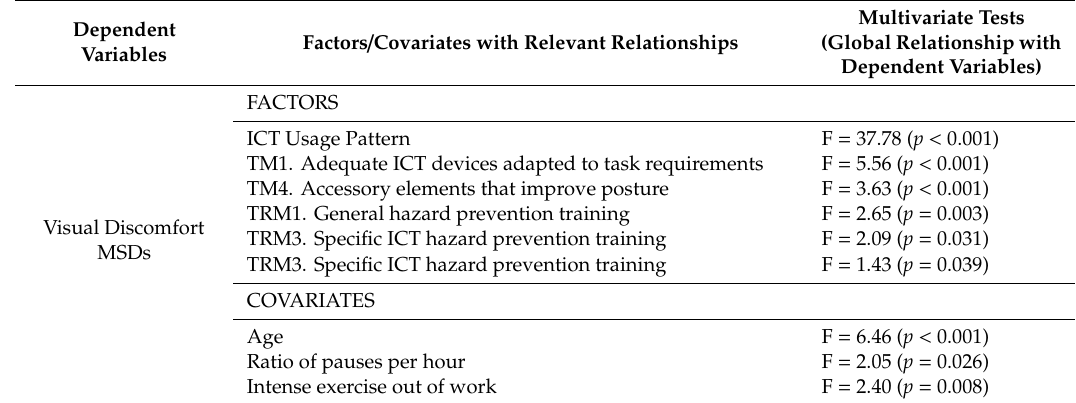
Table 6. Relationship between visual discomfort, MSDs, ICT usage patterns, and preventive measures. MANOVA: Multivariate